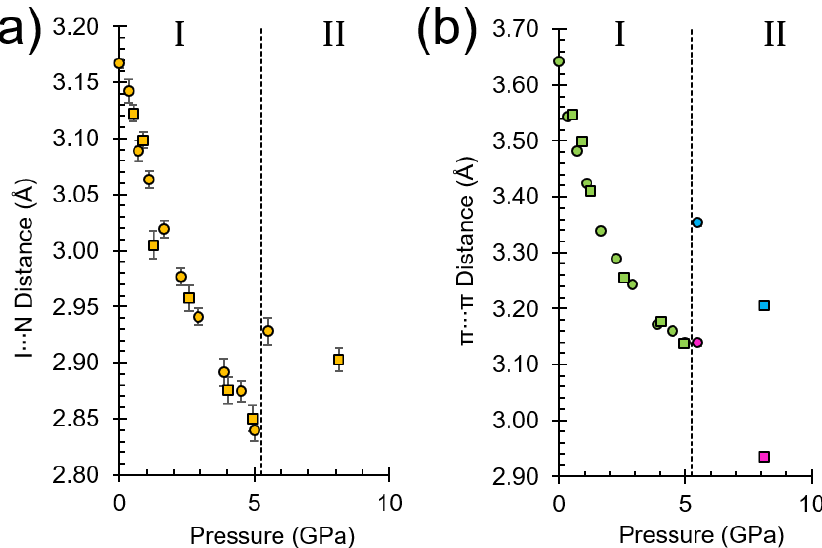
Figure 6. ( a ) Change in the axial I ··· N distance relating to contacts G and H as a function of pressure. Circles represent ex-situ data and squares represent in-situ data. The contacts remain related by symmetry in both phases. ( b ) The change in π ··· π stacking distances between the layers in contacts K and L as a function of pressure. Circles represent ex-situ collected data and squares in-situ collected data. K (blue) and L (purple) contacts split into two symmetry independent contacts in phase II.